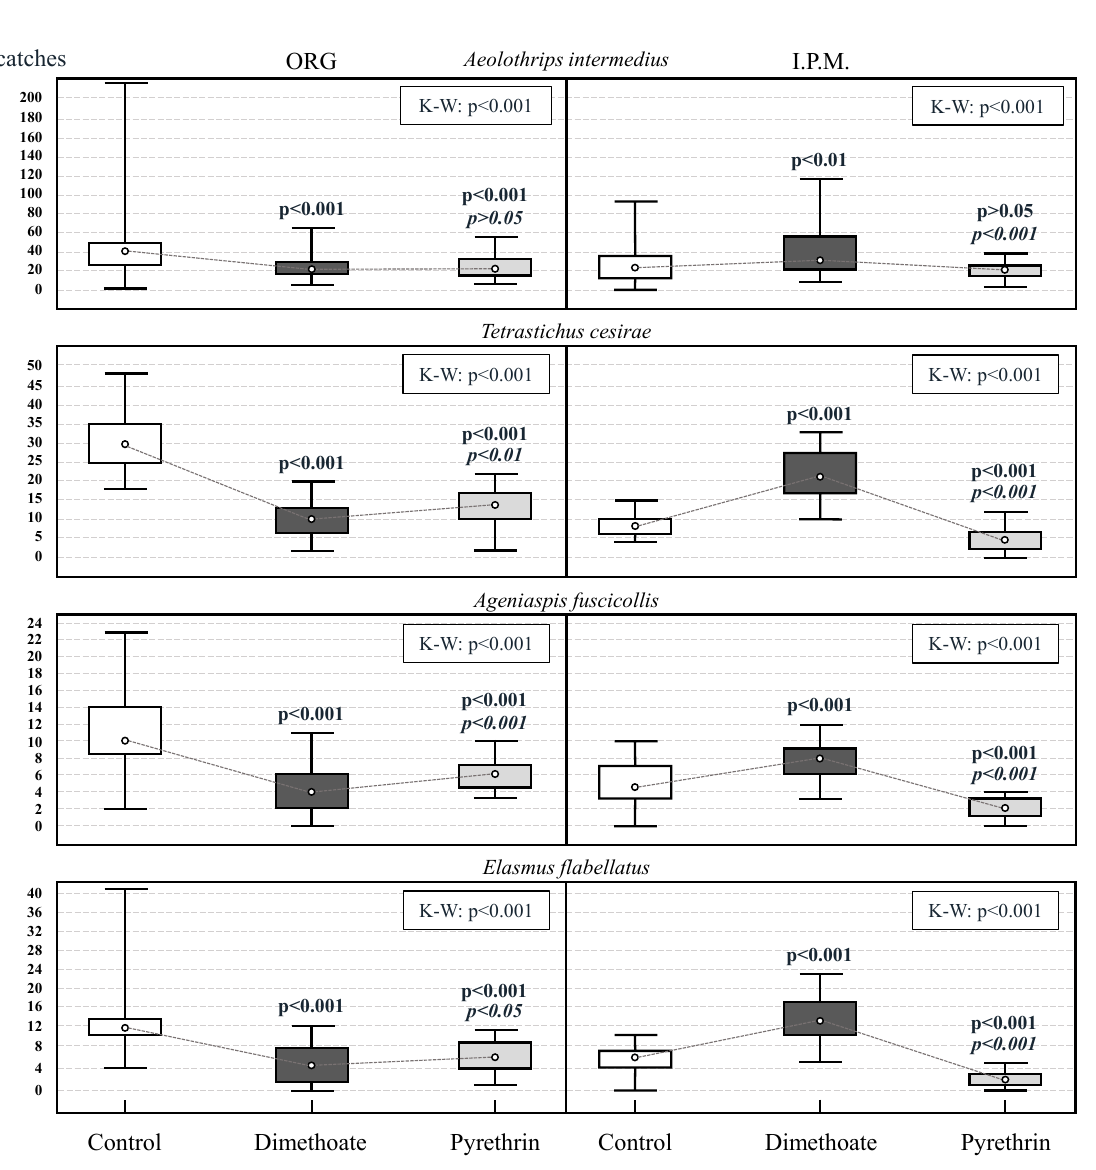
Figure 5. Statistic capture values (median, quartile 25, quartile 75, maximum and minimum) of the main beneficial species in the control plots (white color), treated with organophosphate Dimethoate 40% © (dark color) and pyrethrins (light color), of the two olive groves (organic/IPM). The p -value (Kruskal–Wallis test) is indicated in the upper right corner. The p -values indicated above the boxplots correspond to the comparison with respect to the control plot ( bold letters ) and between the two insecticides ( italic letters ).